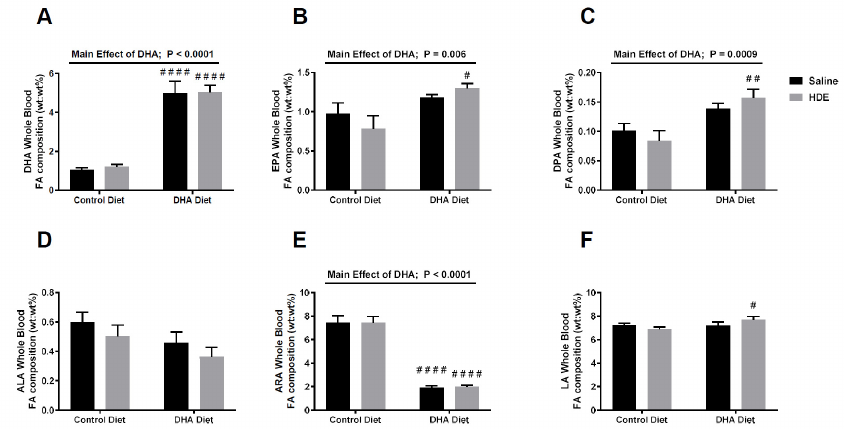
Figure 1. Fatty acid blood levels collected from the docosahexaenoic acid (DHA)- and control-diet-fed mice 5 h after the instillation of HDE or saline. Fatty acid blood levels of n-3 PUFA DHA ( A ), eicosapentaenoic acid (EPA) ( B ), docosapentaenoic acid (DPA) ( C ), alpha-linolenic acid (ALA) ( D ) and n-6 PUFA arachidonic acid (ARA) ( E ) and linoleic acid (LA) ( F ), measured in mice following administration of a diet and exposure. Significance for the main effect of the DHA diet is shown with the p -values and significance bars on top of the DHA, EPA, DPA, and ARA graphs. Tukey post hoc comparisons between the DHA- and control-diet-treated conditions are annotated with the # symbol. (# p < 0.05; ## p < 0.01; #### p < 0.0001).